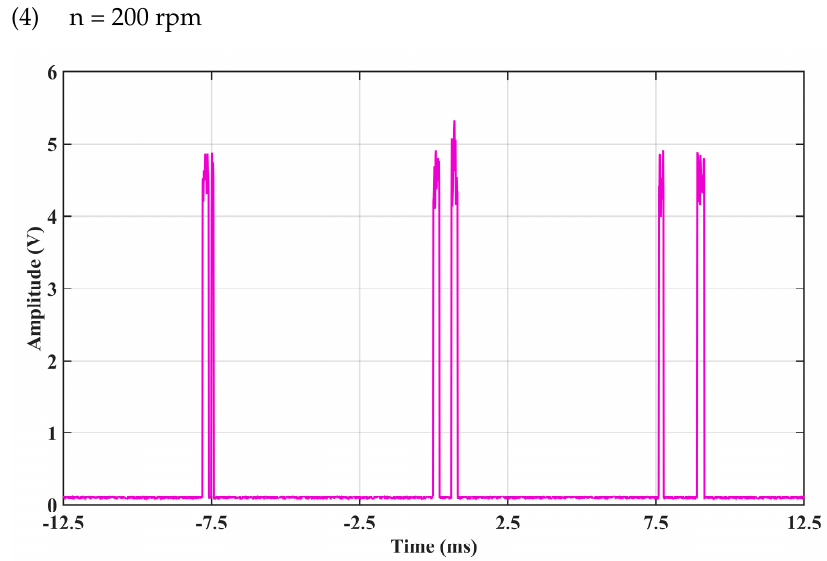
Figure 5. The 200 rpm oscilloscope waveform.